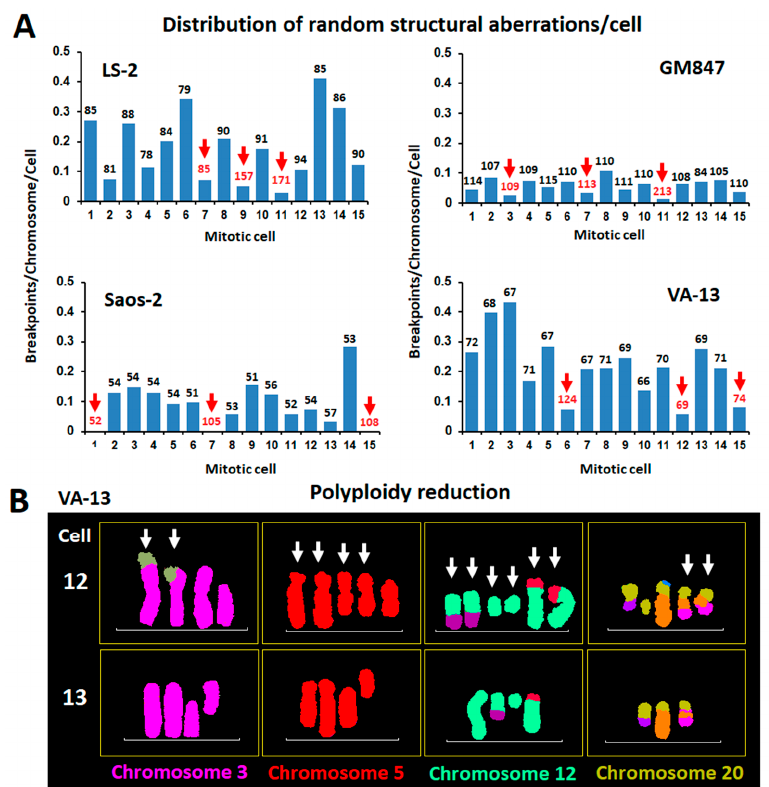
Figure 2. Distribution of random structural chromosomal instability in neoplasia (CIN) among co-dividing alternative lengthening of telomeres (ALT) cells and the possible role of WGD in the perpetuation of the integrity of driver chromosomal rearrangements. ( A ) Uneven distribution of non-clonal structural chromosomal rearrangements between 15 randomly picked, co-dividing cells from 4 human ALT cell lines. Bars indicate structural CIN load, calculated as breakpoints / chromosome. Chromosome number / metaphase is indicated above each data bar. From every cell line we selected 3 cells with the lower rates of structural chromosomal instability. Interestingly, half of the 12 CIN escapee cells (red arrows and numbers) were byproducts of WGD or showed evidence of WGD reduction. ( B ) Pseudo-colored partial karyograms of two co-dividing VA-13 mitotic nuclei belonging to the major clones and each bearing 69 chromosomes. In contrast to #13, cell #12 displays extremely low rates of structural CIN and presents several duplicated copies of clonal recombinant chromosomes, suggesting WGD followed by multiple chromosome